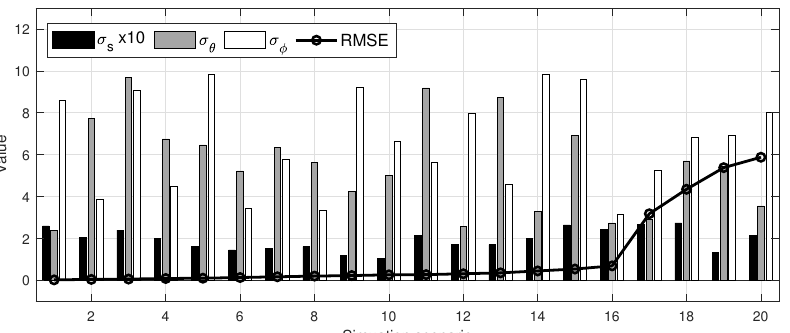
Figure 8. (Top) The RMSE results of the conducted Monte Carlo 20 simulation scenarios at various sensors’ noise